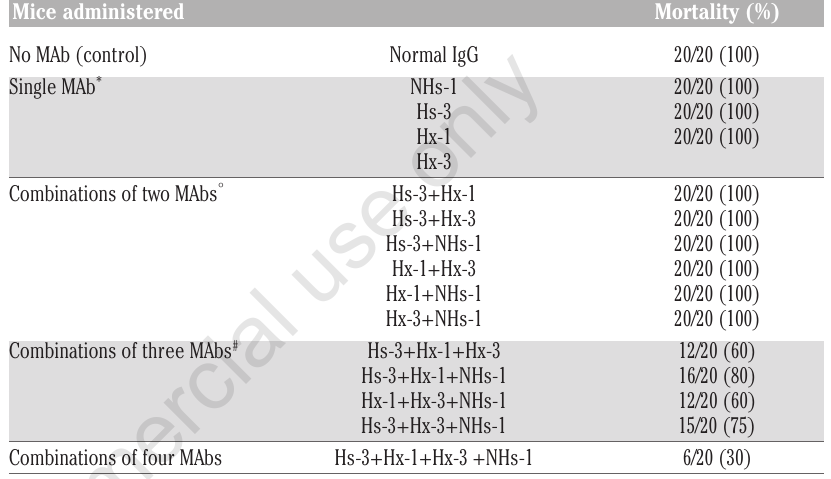
Table 1. Mortality of Japanese encephalitis virus (strain 641686)-infected mice passively given single monoclonal antibodies to Japanese encephalitis virus glycoprotein E and